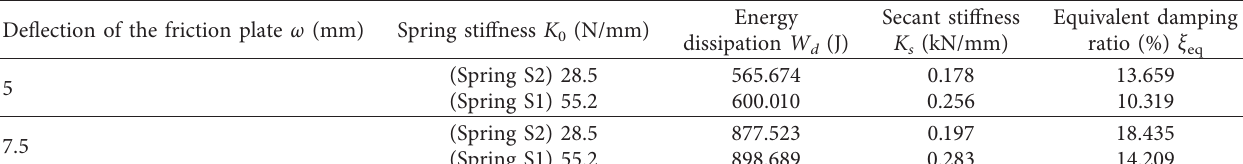
Table 4: Performance parameters of SCVF brace with different springs.